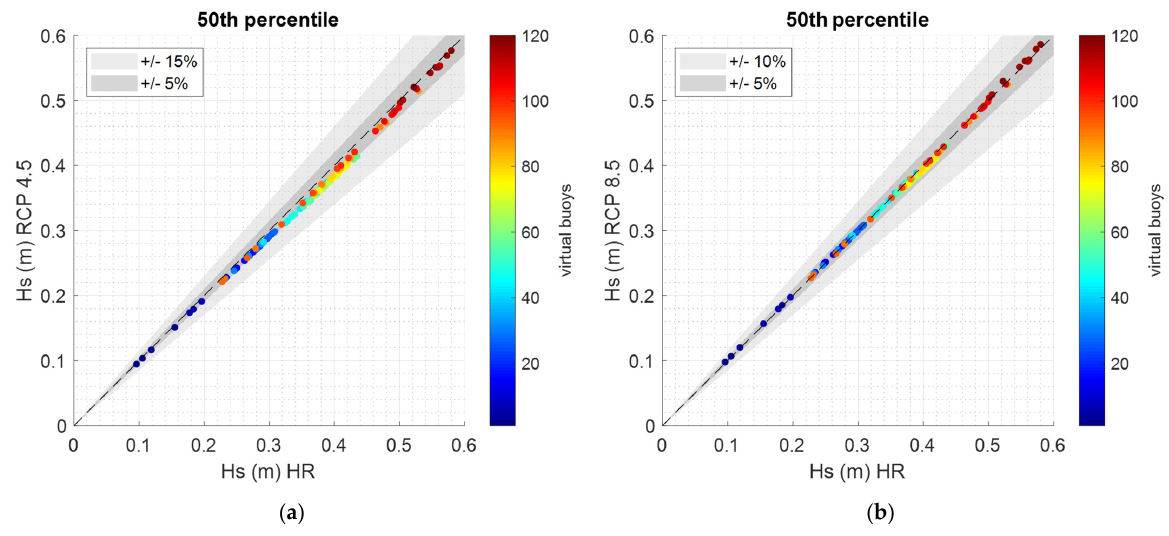
Figure 3. Comparison between the 50th percentiles of the significant wave heights Hs computed at the 120 virtual buoys along the Italian Adriatic coast relative to the historic run (HR) and future scenario runs: ( a ) historic run vs. RCP 4.5 scenario; ( b ) historic run vs. RCP 8.5 scenario.